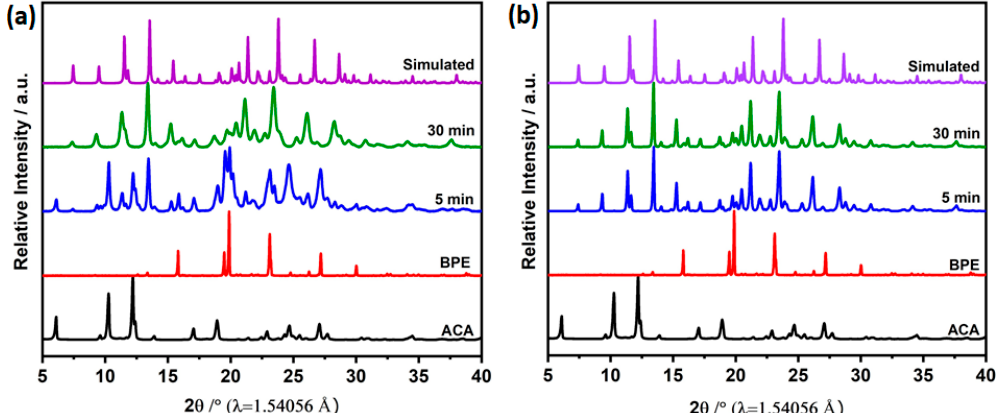
Figure 3. PXRD patterns of 9-anthracenecarboxylic acid (ACA), 1,2-bis(4-pyridyl)ethane (BPE), and the mechanochemically synthesized ACA-BPE cocrystal with respect to different time intervals with ( a ) neat grinding (NG) and ( b ) liquid-assisted grinding (LAG) with MeOH.